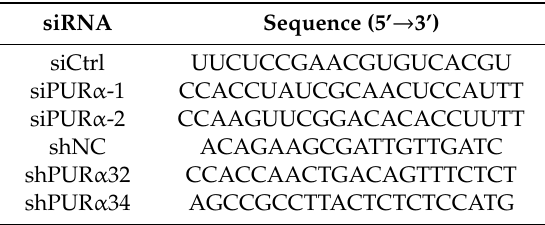
Table 5. siRNA / shRNA sequences of PUR α